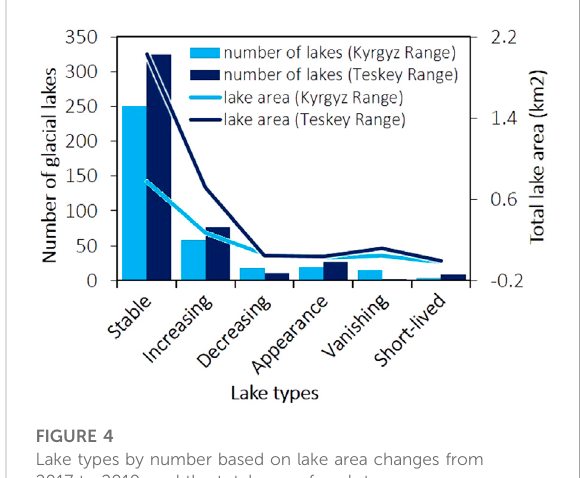
FIGURE 4 Lake types by number based on lake area changes from 2017 to 2019, and the total area of each